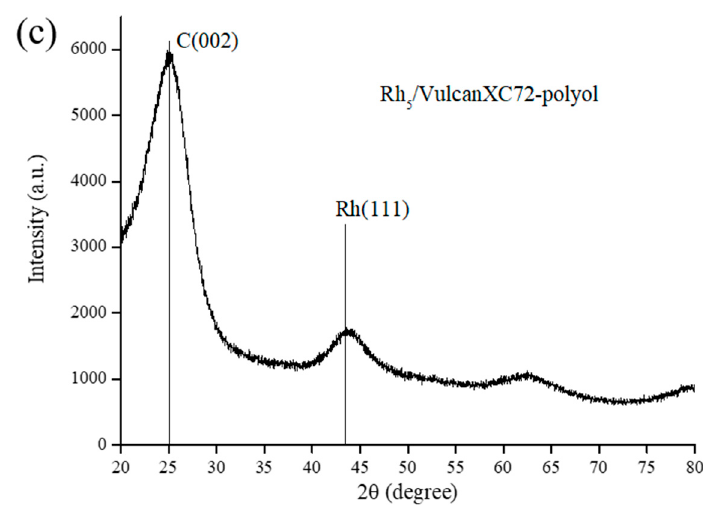
Figure 1. Morphology of Rh 5 /VulcanXC72-polyol as its ( a ) HRTEM image with Rh NPs located on the outer surface of the catalyst as indicated by the white arrows, ( b ) corresponding histograms of average particle size analysis and ( c ) X-ray diffractogram.